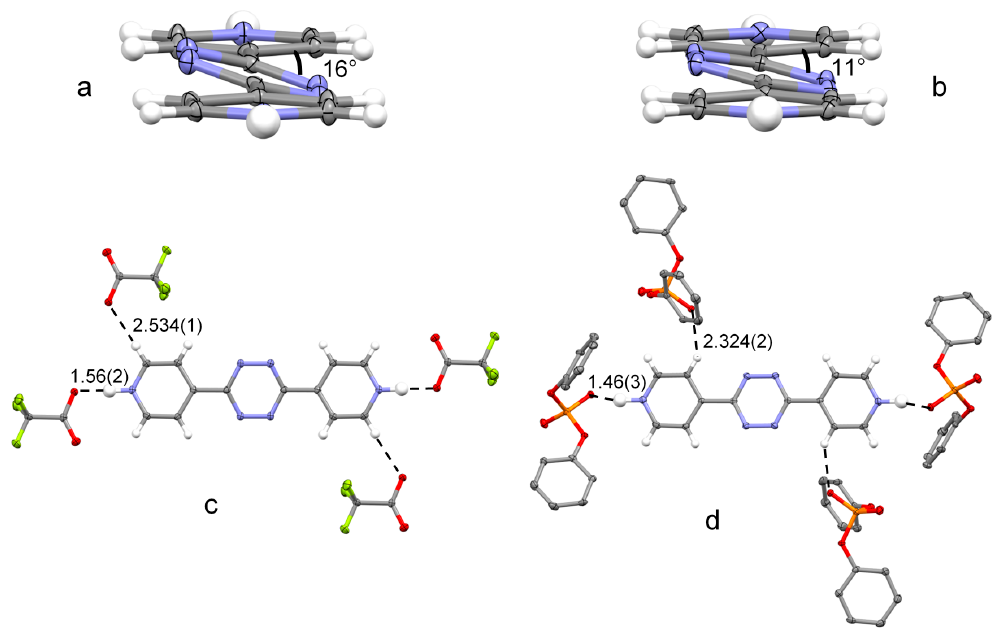
Figure 2. Overall planar conformation assumed by L in ( a ) H 2 L(CF 3 CO 2 ) 2 and ( b ) H 2 L(Ph 2 PO 4 ) 2 , and main intermolecular interactions in the crystal packing of ( c ) H 2 L(CF 3 CO 2 ) 2 and ( d ) H 2 L(Ph 2 PO 4 ) 2 . All distances are in Å. Thermal ellipsoids are drawn at the 50% probability level. Color code: C, grey; H, white; N, blue; O, red; P, orange; F, greenish yellow.